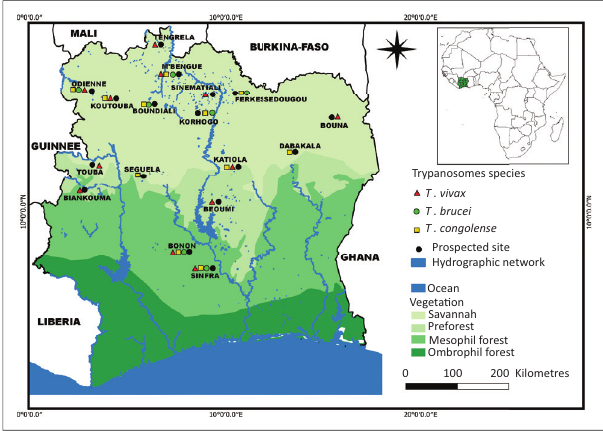
FIGURE 2: Distribution of the trypanosome species circulating in cattle in Côte d’Ivoire based on studies published between 1960 and 2021 included in the systematic